Question: In one sentence, what is this figure communicating?
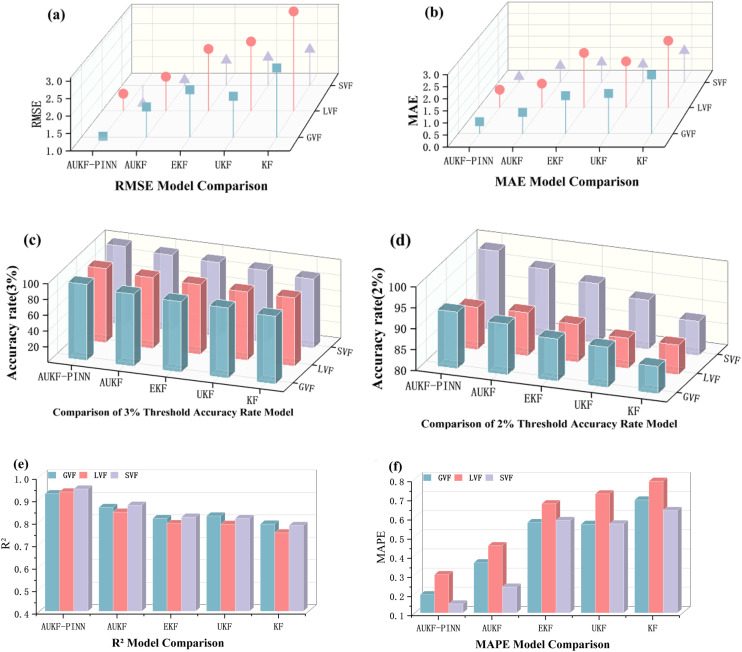
Answer: Model Performance Comparison Chart.